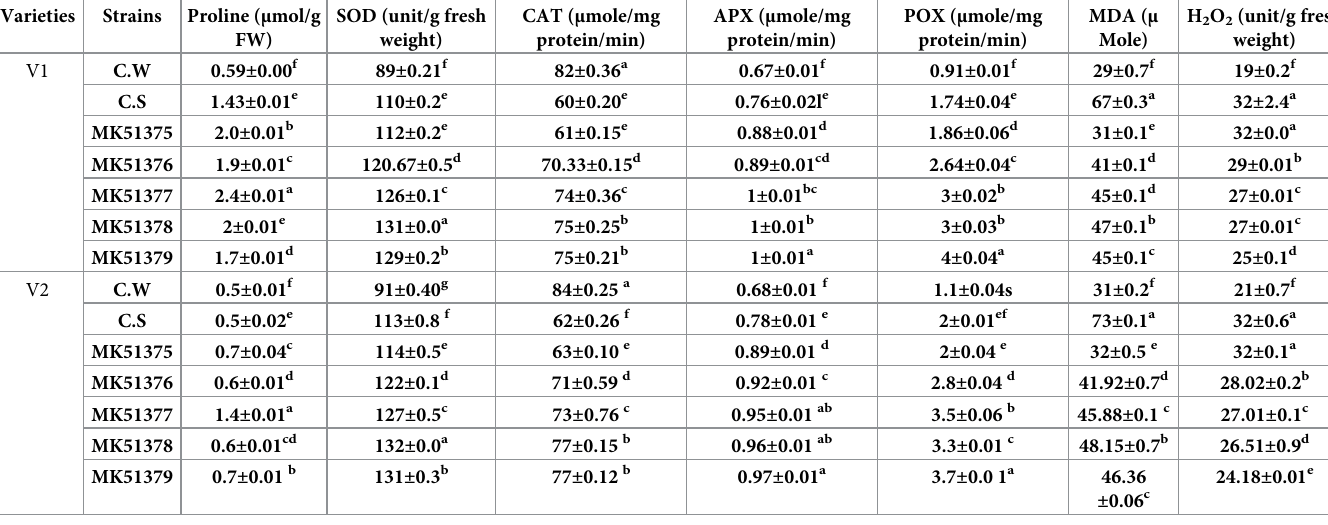
Table 4. Effect of IAA producing PGPR on enzymatic pool of Vigna radiata in field trials.